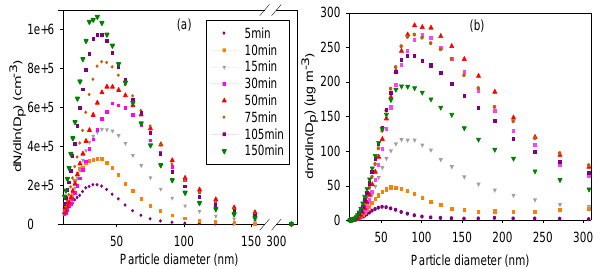
Figure 5. Evolution of particle number (a) and mass (b) size distri- butions for nebulized solutions sampled at different reaction times for experiment B, measured by means of SMPS. The standard devi- ations are smaller than the width of the symbols.